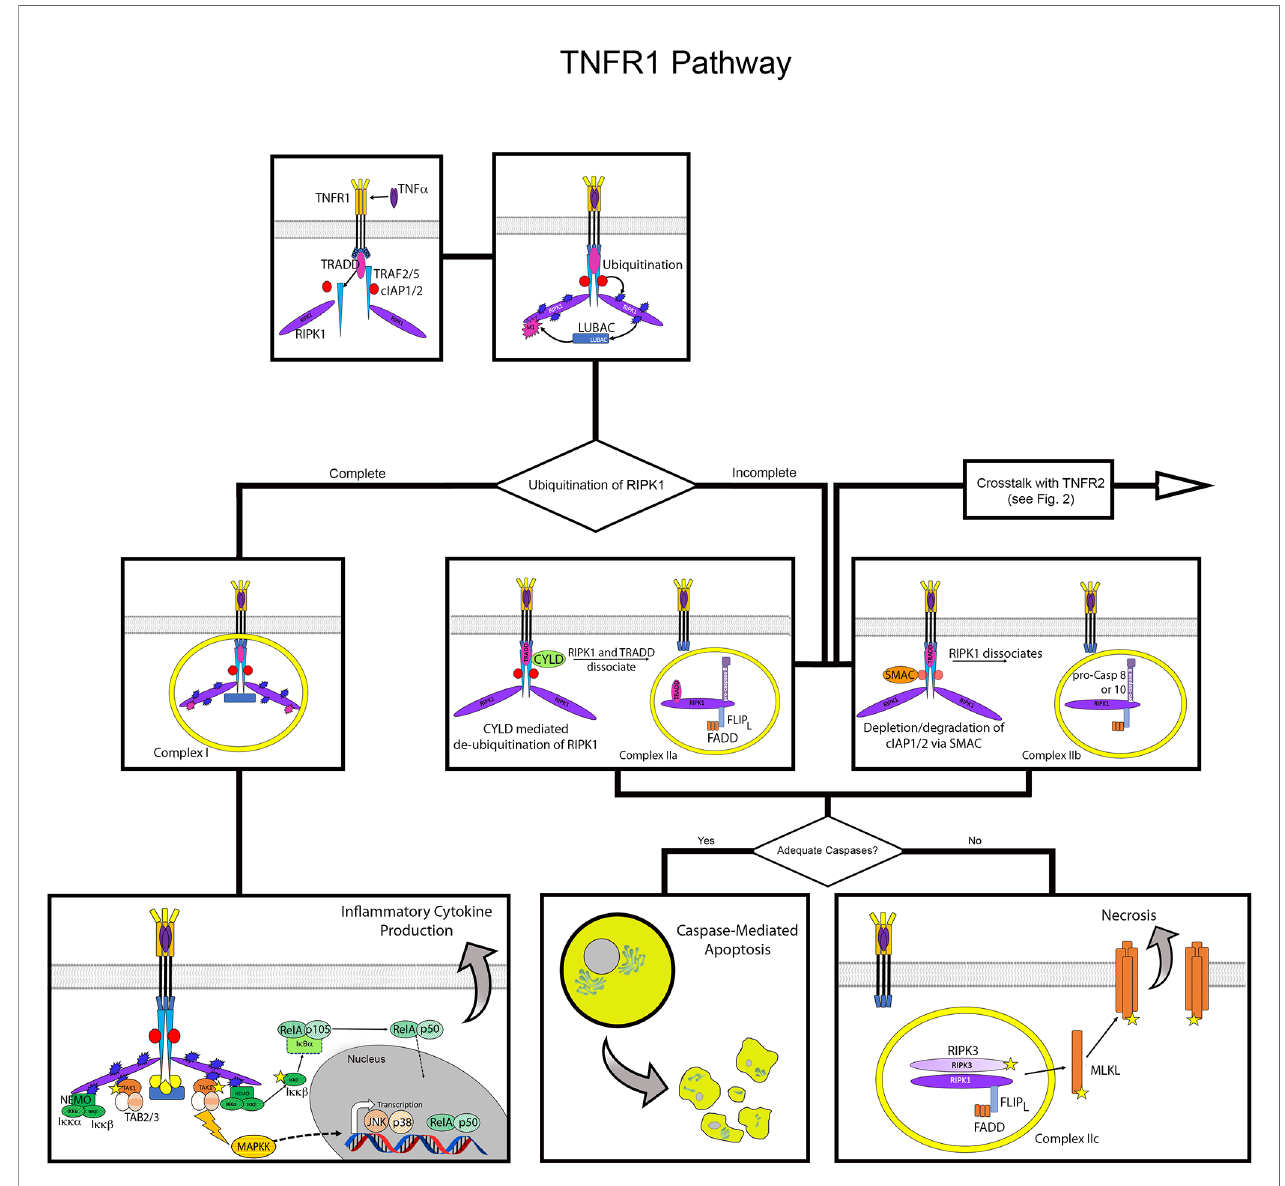
FIGURE 1 | Overview of TNFR1 activation pathway. Flow diagram for TNFR1 activation contrasting the outcomes of in fl ammatory cytokine production versus cell death. The top panels depict formation of the core signaling complex with recruitment and assembly of TRAF2/5, cIAP 1/2 and RIPK1 at the death domain of TNFR1, and subsequent recruitment of LUBAC. The middle and lower panels show the divergence of potential pathways from formation of the core complex. On the left, complete ubiquitination of RIPK1 results in formation of Complex I, which leads to recruitment of NEMO and TAK1 that activate NF k B and JNK, respectively. On the right, incomplete ubiquitination of RIPK1 leads to formation of complex IIa or IIb, with assembly of FLIP L , FADD and pro-caspase 8 or 10, leading apoptosis via activation of the latter. Below this, the formation of Complex IIc in the absence of suf fi cient caspases leads to necroptosis via activation of MLKL via the necrosome formed by assembly of RIPK1 and RIPK3. Stars indicate phosphorylation, blue bursts represent ubiquitination, purple bursts represent M1